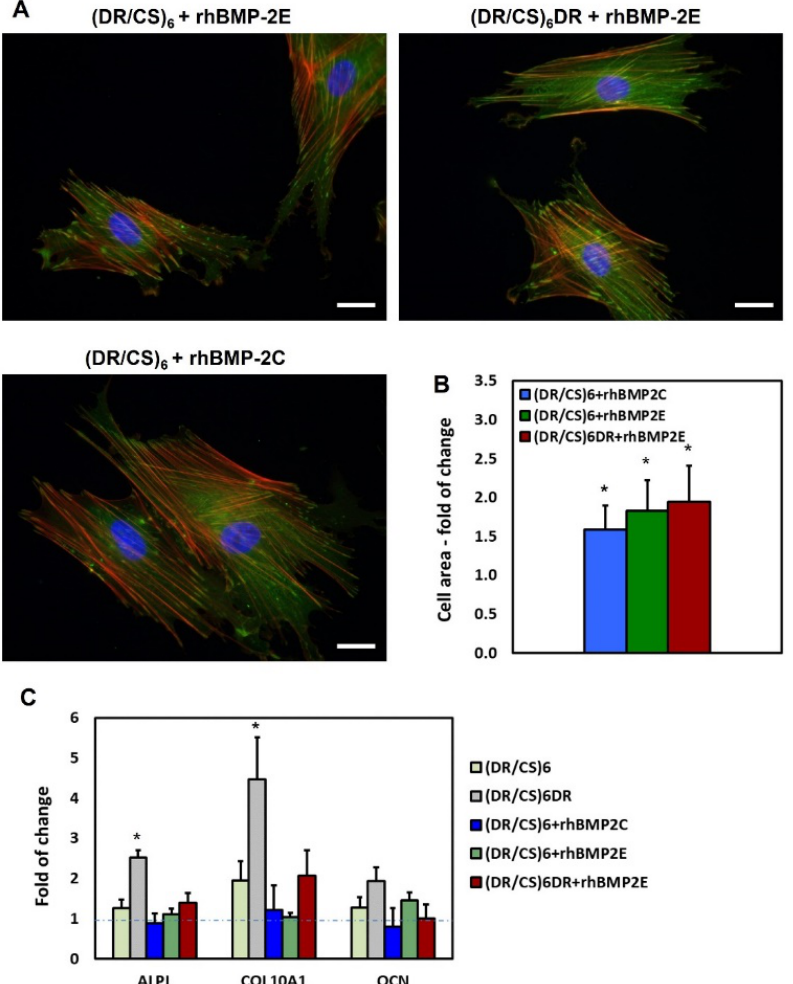
Figure 7. ( A ) Changes in the actin cytoskeleton architecture of hUC-MSCs cultured on selected surfaces with immobilized rhBMP-2. Cells were cultured in a medium supplemented with 2% FBS for 24 h and were then immunostained for vinculin and counterstained with TRITC-phalloidin (F-actin) and DAPI (nuclei). The scale bar represents 25 μm. ( B ) Cell area after 24 h of seeding measured for 30 cells for each condition, shown as the fold-change vs. appropriate pure polymeric systems (controls). ( C ) Expression of osteogenic markers in hUC-MSCs cultured on selected surfaces for seven days. Quantitative real-time PCR analysis of selected osteogenic markers (ALPL–alkaline phosphatase; COL10A1–collagen type 10; OCN–osteocalcin) in hUC-MSCs cultured in DMEM/F12, 2% FBS. Gene expression was normalized to the expression of a housekeeping gene–GADPH, shown as the fold-change compared to gene expression in hUC-MSC cultured on the clean substrate–glass coverslips (blue line). p values less than 0.05 ( p < 0.05) were considered statistically significant in comparison to the control and are labeled by an asterisk